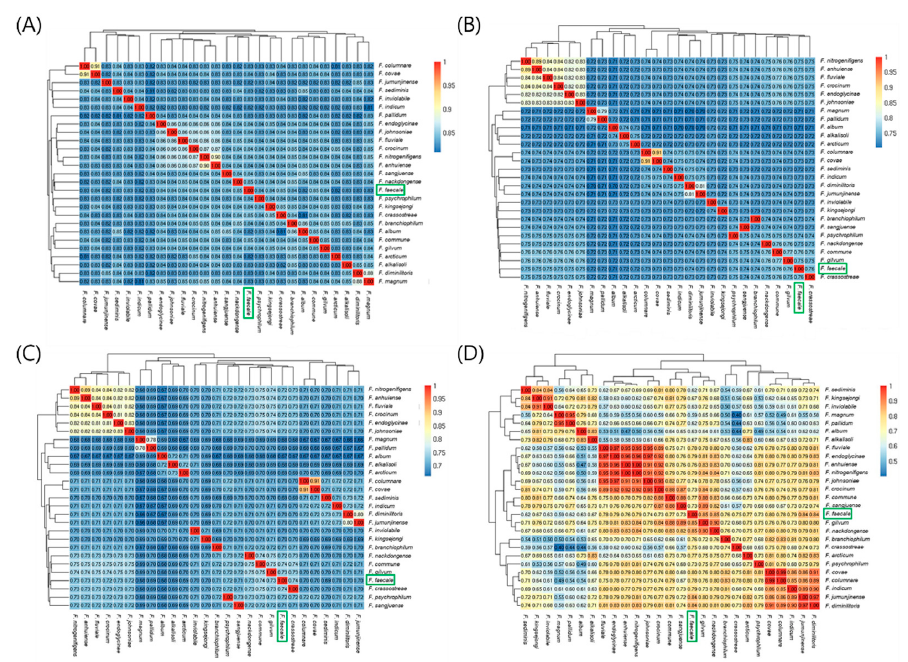
Figure 3. Average nucleotide identity (ANI) analysis of the 27 representative genomes of Flavobacterium strains including F. faecale WV33 T . ANI analysis was performed using pyani with ANIm ( A ), ANIb ( B ), ANIblastall ( C ), and TETRA ( D ) algorithms. ANI similarities with 1 being identical are indicated in the heatmaps. Scale of similarity values are represented by a continuous color gradient. A similarity value is presented in each cell. Green box represents F. faecale WV33 T (GCF 003076455.1).